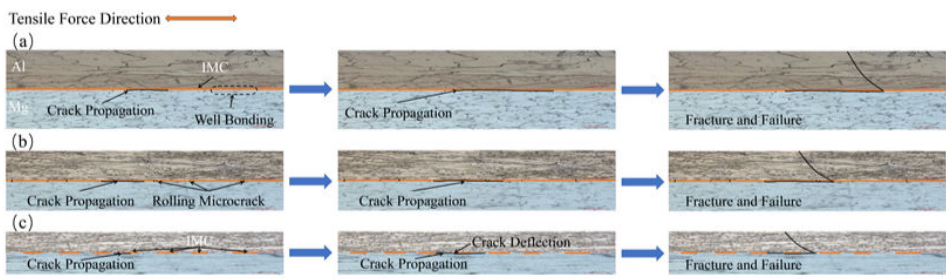
Figure 12. Schematic diagram of crack propagation: ( a ) not rolled, ( b ) second pass, ( c ) fourth